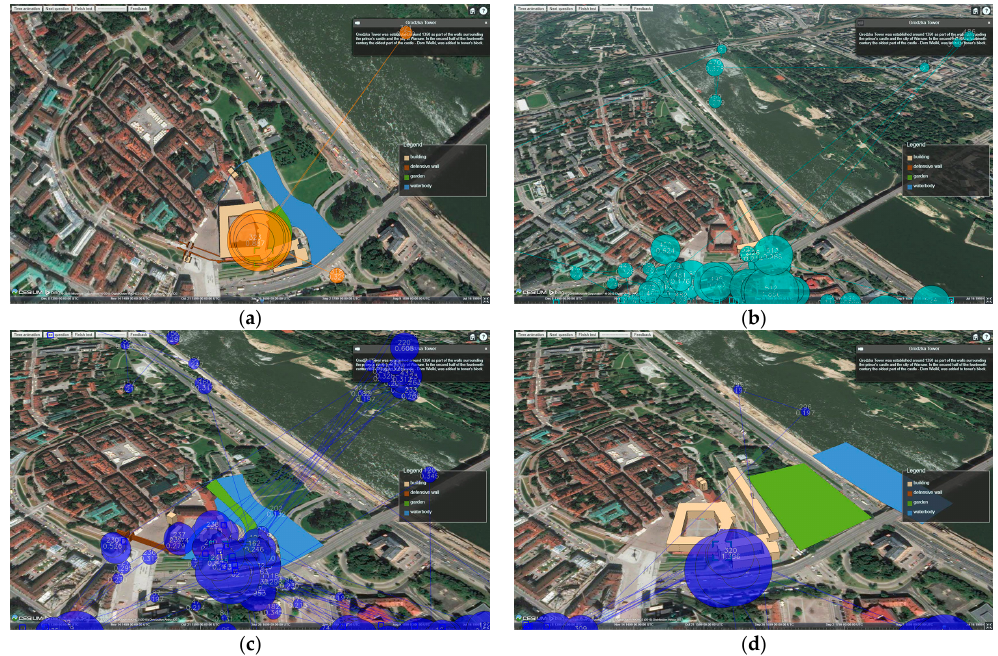
Figure 16. Searching strategies for Q3 in the slider-based visualization: ( a ) overview, temporal filter, and details-on-demand; ( b ) overview and temporal filter; ( c ) overview, temporal filter, and details-on-demand; ( d ) overview and temporal filter with focus on edge time values.